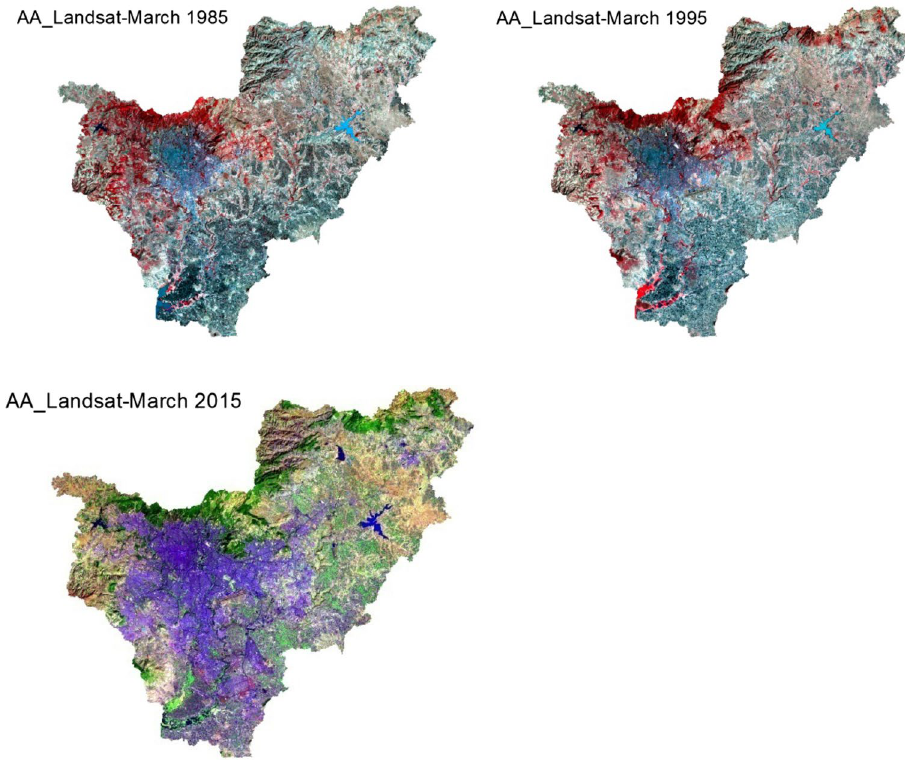
Fig. 7 False color composite